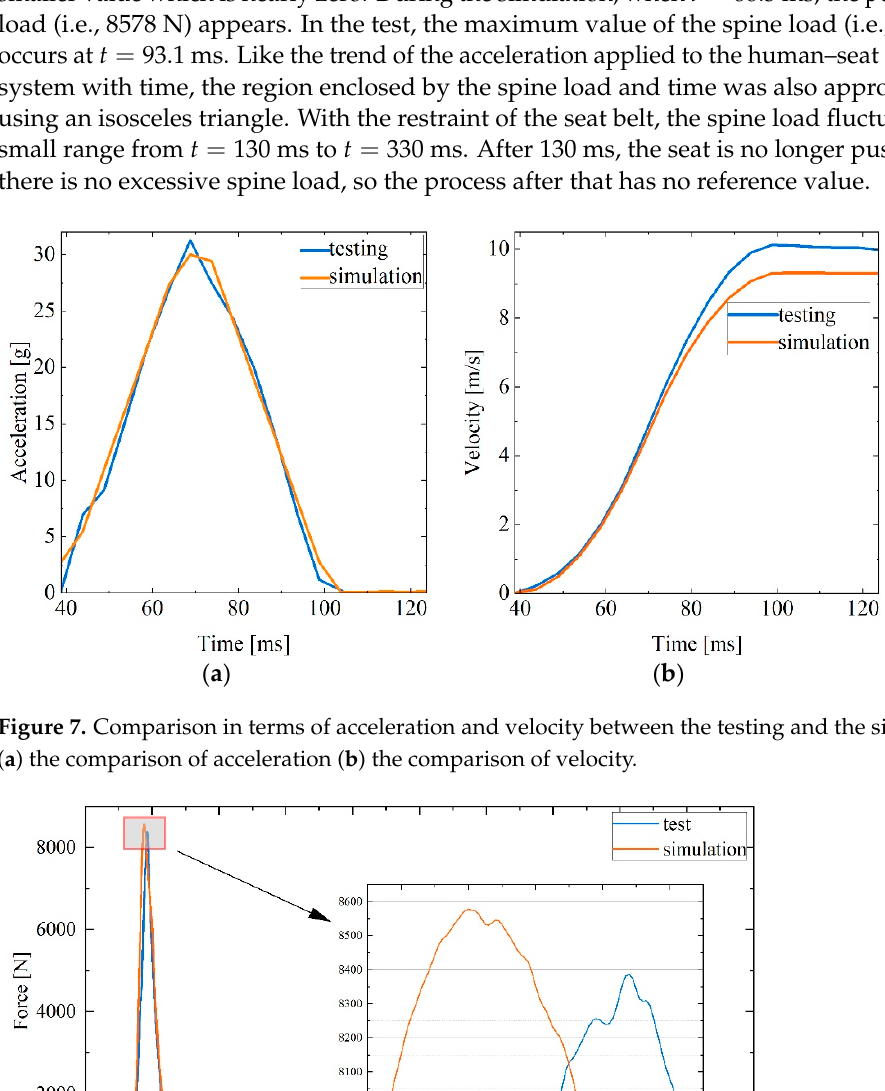
Figure 6. A frame during the process of the test